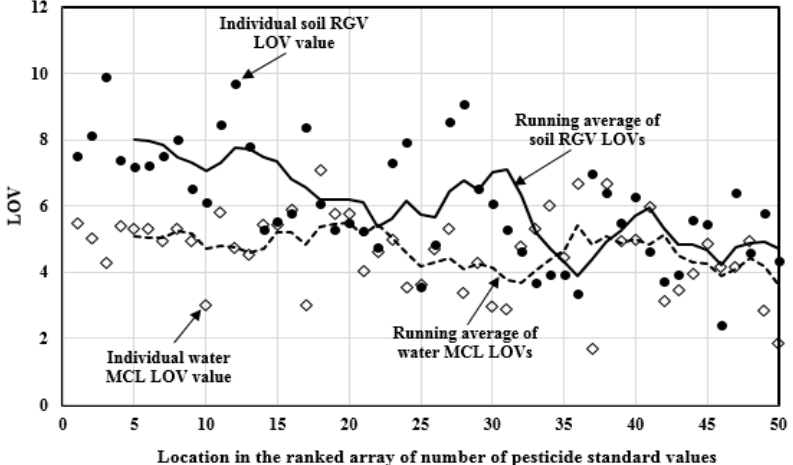
Figure 4. Log orders of variation (LOV) values and the running average for the commonly regulated pesticides in soil and drinking water.